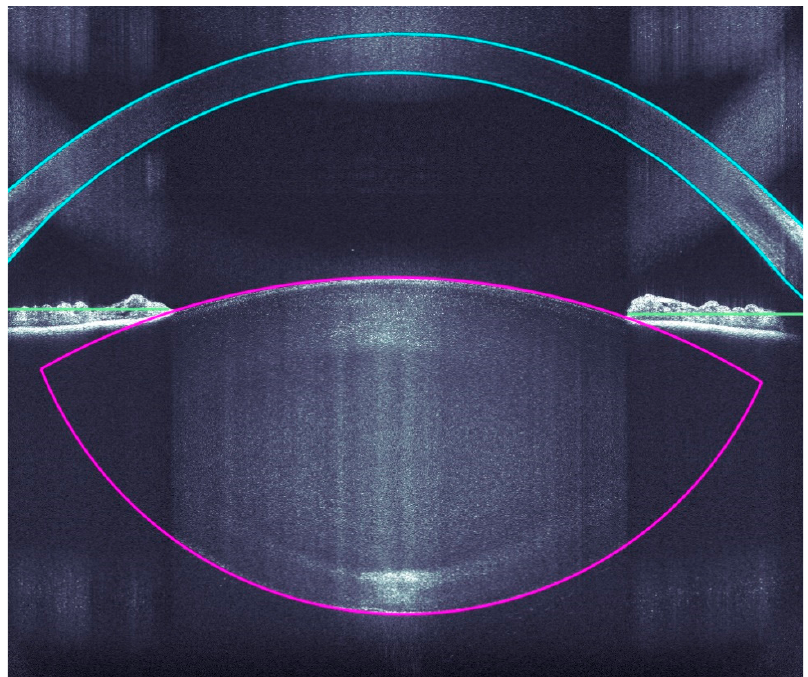
Figure 2. Intraoperative analyses of all ocular structure.